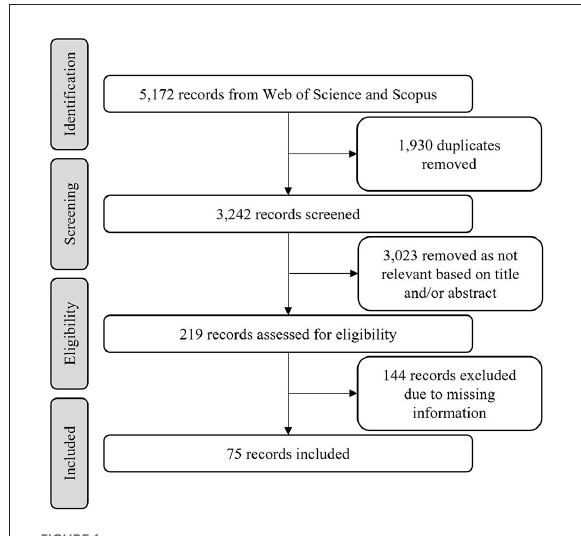
FIGURE1 Flow diagram for the selection of articles used in our